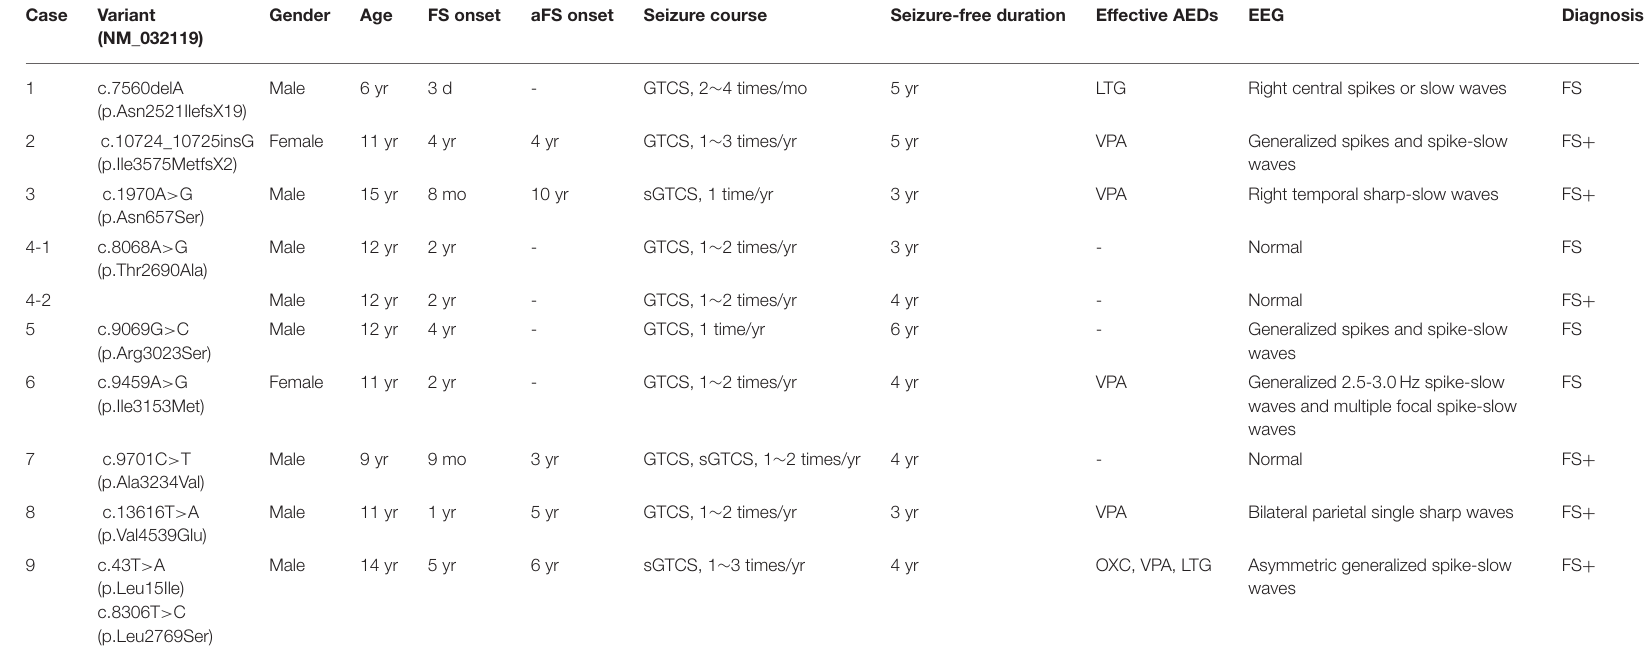
TABLE 1 | Clinical features of individuals with ADGRV1